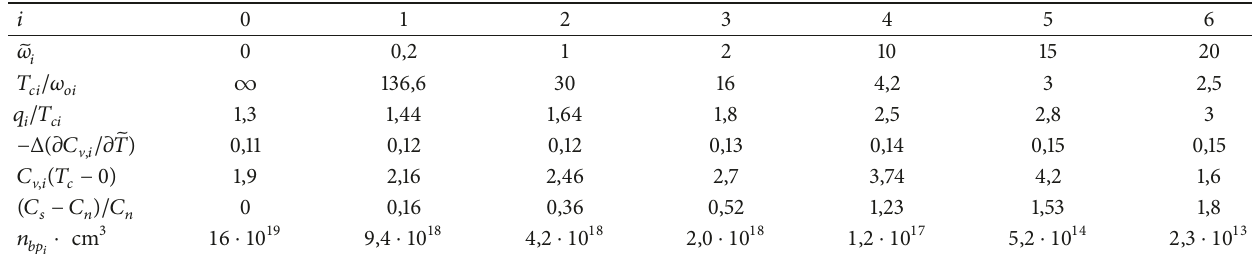
Table 1: Calculated characteristics of Bose gas of TI-bipolarons with concentration 𝑛 = 10 21 cm −3 .